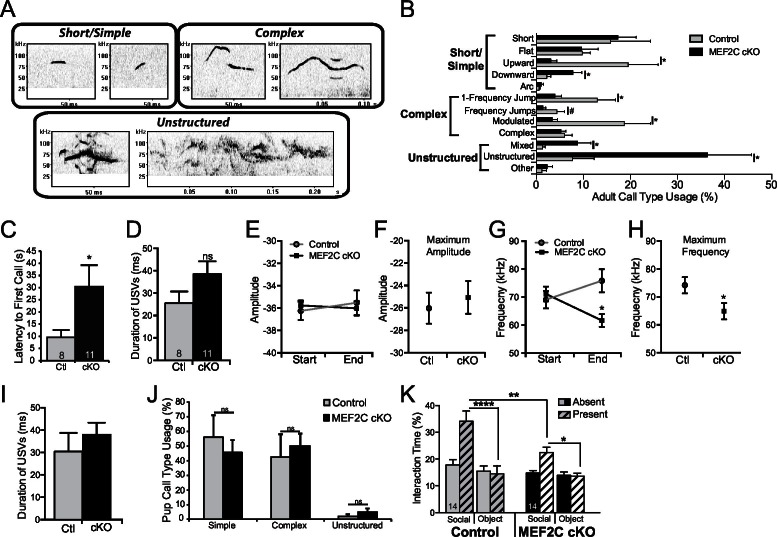
Characterization of Mef2c cKO mouse USVs.(A) Representative images of the different classes of call types, modified from previous studies (Shalizi and Bonni, 2005). Example of different USV types: Short/Simple (flat and upward), Complex (1-Frequency jump and complex), and Unstructured (mixed and unstructured), respectively. (B) Breakdown of the call usage frequency of each sub-type of USVs emitted by adult Mef2c cKO male mice to an estrous female mouse. (C) Adult Mef2c cKO male mice take longer to emit the first USV to an estrous female. (D) No significant difference in the average duration of each adult USV was observed between control and Mef2c cKO mice. (E) No change in USV amplitude was recorded at either the start or end of each call. (F) The average maximum amplitude of USVs was not different between control and Mef2c cKO mice. (G) Mean frequency of adult USVs at the start and end of each call. While both genotypes show the same average start frequency for each USV, control mouse USVs ended at a higher frequency than the call started while Mef2c cKO mice show reduced frequency at the end of the call. (H) The average maximum frequency for USVs was reduced in Mef2c cKO mice compared to control mice. (I) No significant differences in the duration of USVs from pups during maternal separation were recorded. (J) No difference in the call types (simple, complex, unstructured) was observed between control and Mef2c cKO juvenile mice. (K) Mef2c cKO mice show reduced time interacting with a social target in a 2-choice interaction assay. Time spent interacting with a social target (novel mouse) and novel object (black paper binder) are reported. Solid bars represent empty holding cages (targets absent). Striped bars represent targets present (mouse and object). Data are represented as mean ± SEM. Statistical significance was determined by unpaired t-test (B–D,F,H) or 2-way ANOVA (E,G,J–K). #p<0.10, *p<0.05, **p<0.005, ****p<0.0001. ns = not significant. Numbers of animals (n) are reported in each bar for adult and juvenile mouse USV and social interaction experiments.